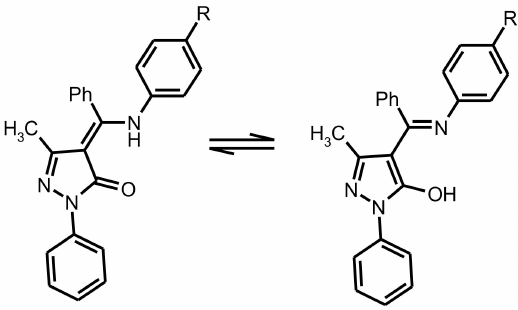
Scheme 3. Transitions between tautomeric forms of ligands upon